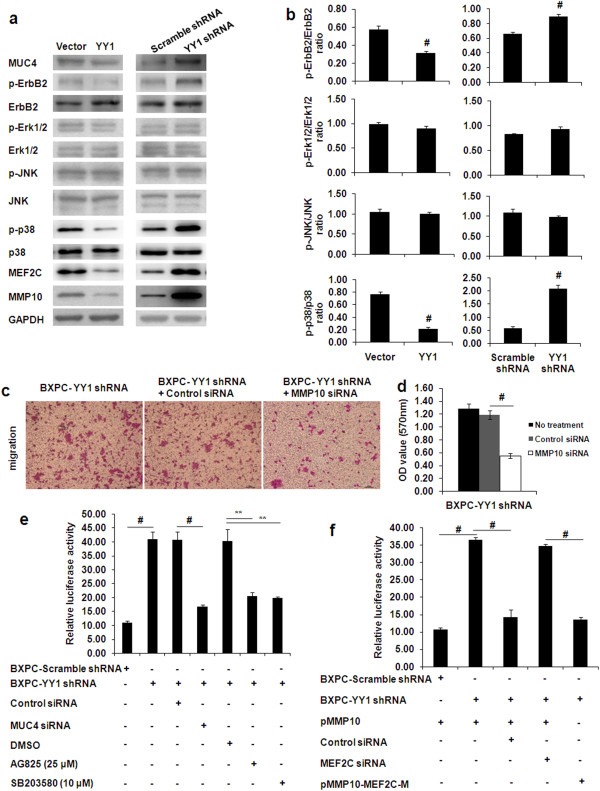
Mechanisms involved in the tumor suppression role of YY1. (a) Effects of YY1 on MUC4, ErbB2, MEF2C, MMP10 and MAPK (Erk1/2, JNK and p38) signaling pathways were assayed by western blotting. BXPC-YY1 indicates YY1overexpressing BXPC-3 cells; BXPC-Vector indicates BXPC-3 cells transfected with a control vector; BXPC-YY1 shRNA indicates YY1 knockdown BXPC-3 cells; BXPC-Scramble shRNA indicates BXPC-3 cells transfected with a vector expressing Scramble shRNA. GAPDH was used as the internal control. (b) Bands were quantified by densitometry. Histograms of the ratio (phosphorylated/constitutive form) for Erk1/2, JNK and p38 MAPK kinases are shown. (c) BXPC-YY1 shRNA cells were transfected with MMP10 siRNA or negative control siRNA. 12 h after transfection, cell migration assays were performed. The upper chambers were seeded with various cell lines. The membranes of the chambers were stained with 0.1% crystal violet. Scale bar, 100 μm. (d) Quantification of the data from Figure 5c. OD values from three independent experiments were assessed. (e) Luciferase activities of MMP10 promoter-transfected BXPC-Scramble shRNA or BXPC-YY1 shRNA cells treated with MUC4 siRNA or various inhibitors of signal transduction molecules. MUC4 blockage, the ErbB2 inhibitor (AG825, 25 μM) and the p38 inhibitor (SB203580, 10 μM) significantly inhibited YY1 knockdown-stimulated luciferase activity in BXPC-YY1 shRNA cells transfected with the MMP10 promoter. (f) The YY1 knockdown-stimulated luciferase activity could be significantly inhibited by MEF2C blockage. Luciferase activity of MMP10 promoter in BXPC-YY1 shRNA cells was significantly decreased when the presumed MEF2C binding site (nucleotides −881 to −890) was mutated. (*represents p < 0.05, **represents p < 0.01, # represents p < 0.001, when compared to the control group).